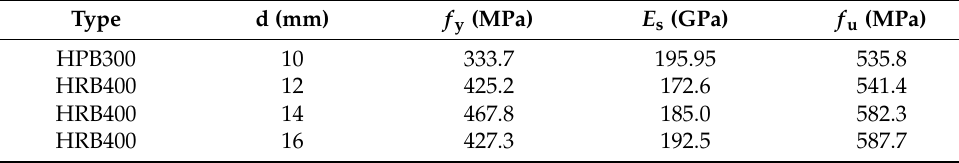
Table 3. Reinforcement’s mechanical properties.